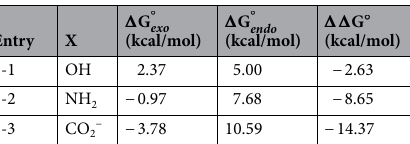
Table 7. Results of the solution-phase DFT calculations on the final products of the three DA reactions outlined in Fig. 1.